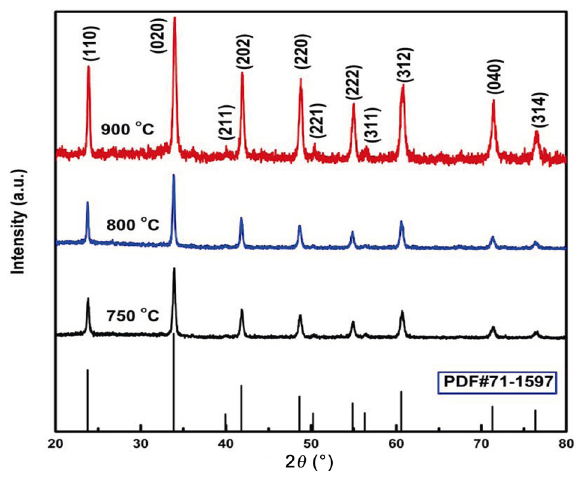
Fig. 3 XRD patterns of SmAlO 3 calcined at different temperatures for 2